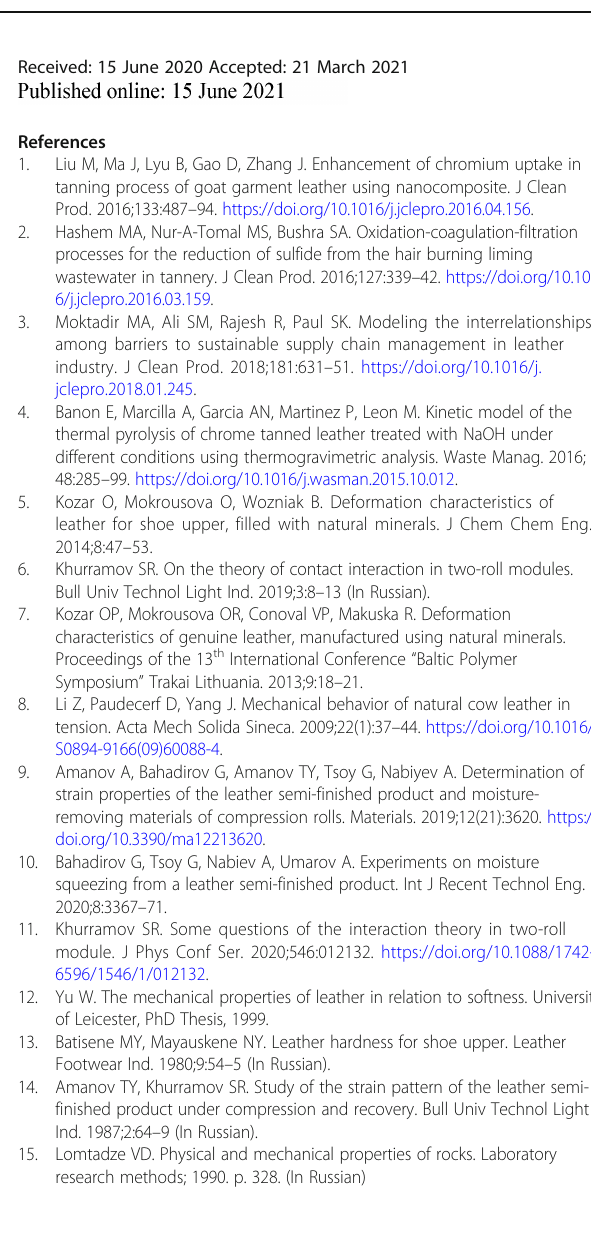
Fig. 6 Dependence of hydraulic gradients on moisture filtration rate through a leather semi-finished product, with various degrees of compression: 1- ε = 0.593; 2- ε = 0.5; 3- ε = 0.407; 4- ε =